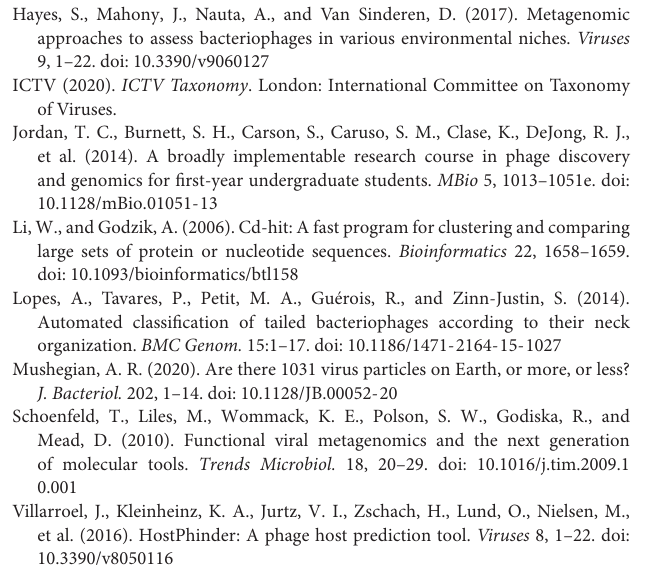
genome concatenated sequence length. Supplementary Table 1 | List of putative phage and archaeal virus species complete